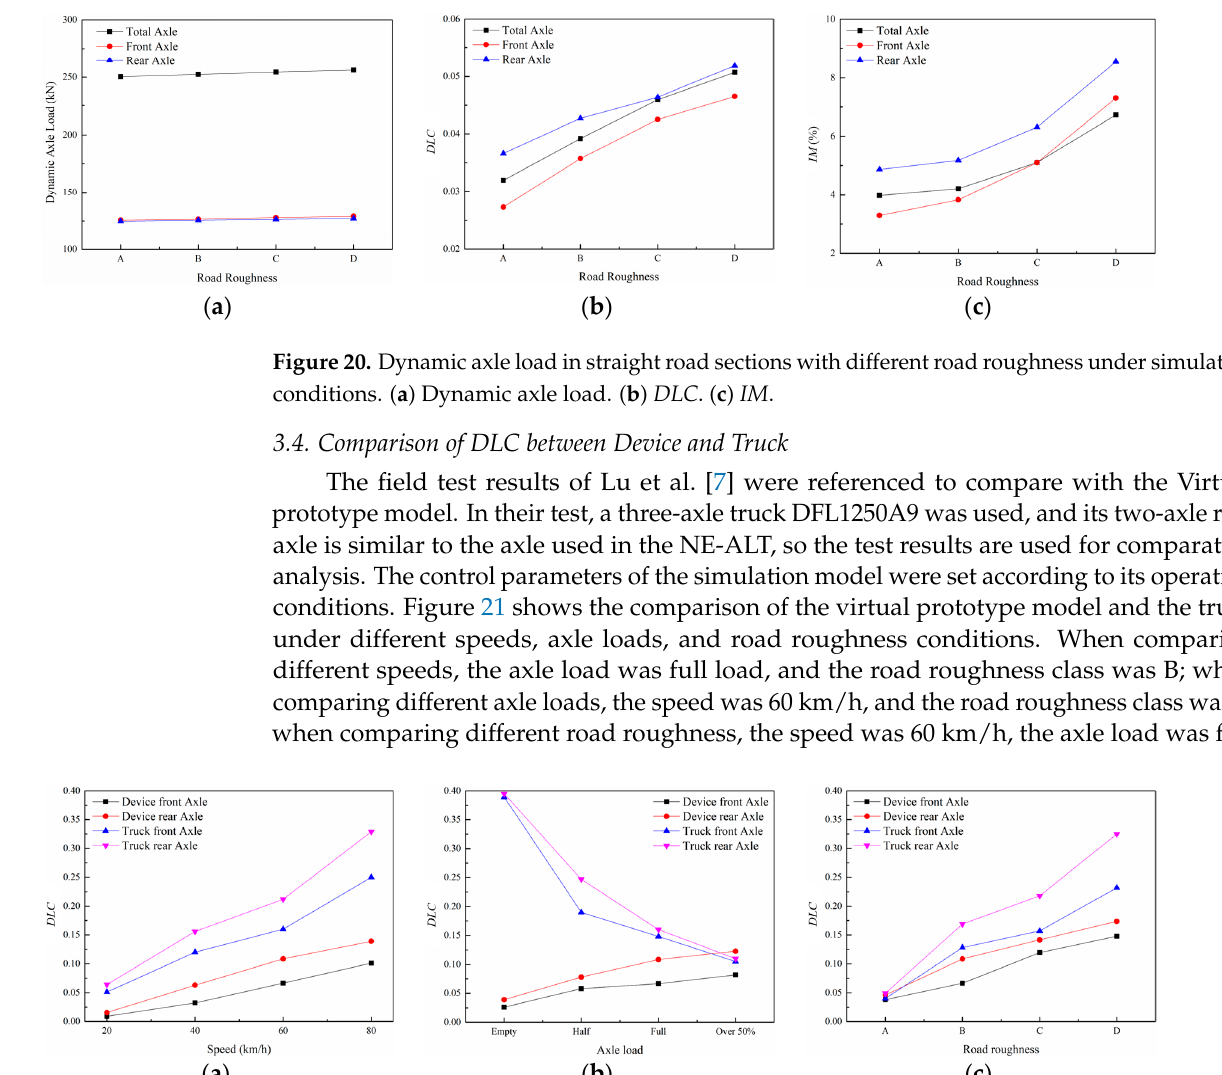
tion conditions. ( a ) Dynamic axle load. ( b ) DLC . ( c ) IM .